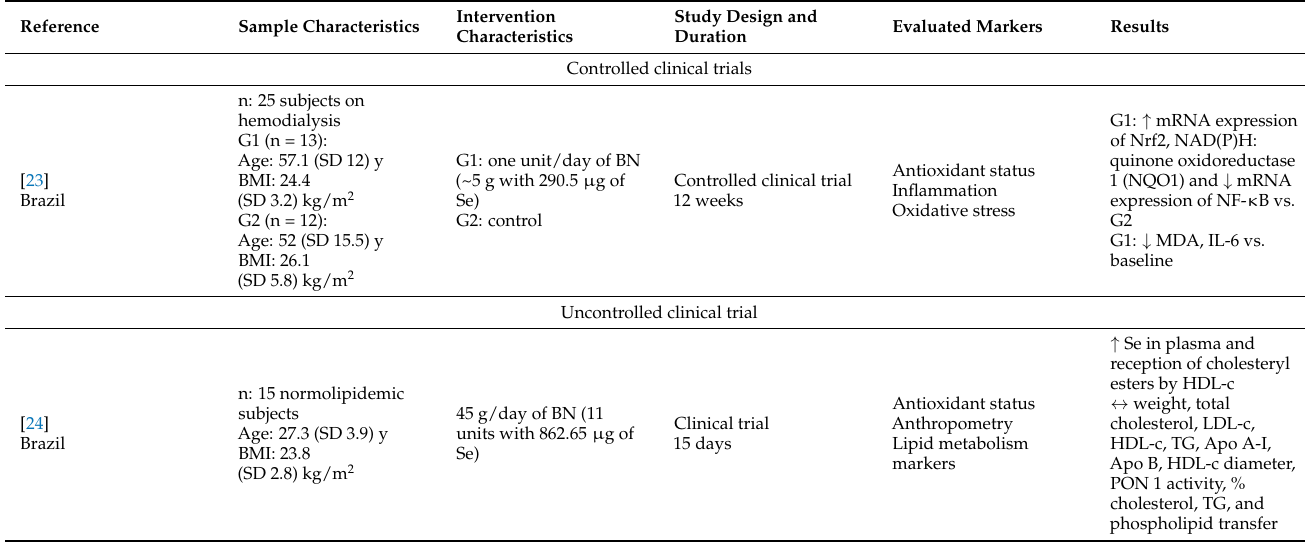
Table 2. Non-randomized clinical trials evaluating the effects of Brazil nut consumption on human health ( n =